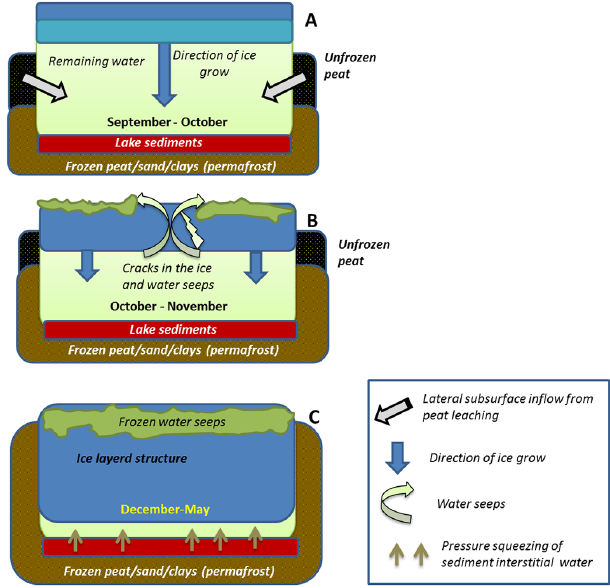
Figure 9. Sequence of ice crystallization events during the glacial period on the shallow ( < 1m depth) thermokarst lakes of western Siberia. (a) Start of the ice formation; (b) squeezing water towards the surface via seeps; (c) freezing of water pockets and seeps and multi-layer ice